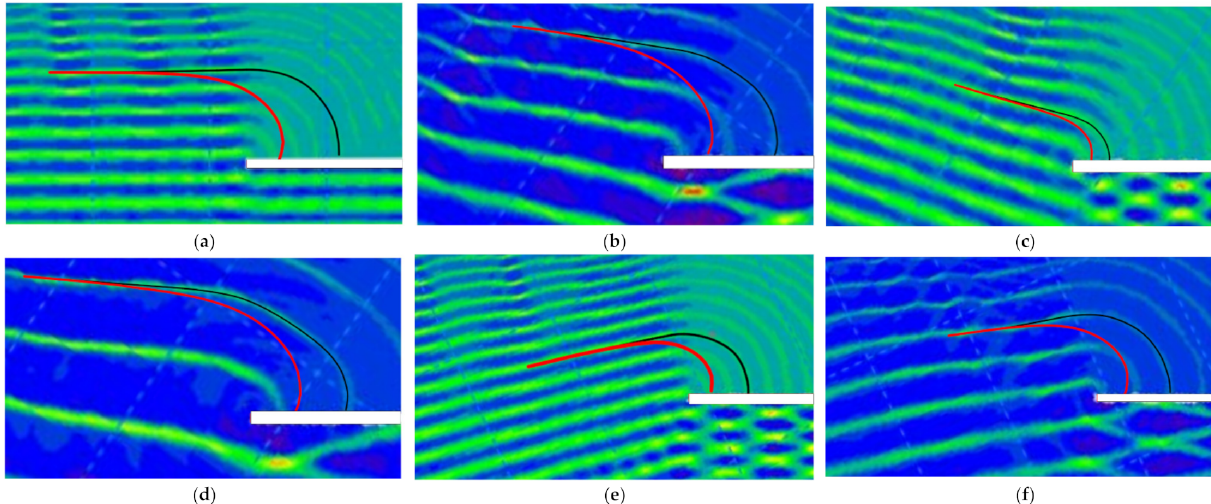
Figure 9. Comparisons between wave fronts (black line) and hyperbolic tangent profiles (red line): ( a ) wave direction 0 ◦ , wave period 6 s, gentle slope configuration; ( b ) wave direction − 35 ◦ , wave period 10s, gentle slope configuration; ( c ) wave direction − 35 ◦ , wave period 6s, gentle slope configuration; ( d ) wave direction − 35 ◦ , wave period 15 s, gentle slope configuration; ( e ) wave direction 25 ◦ , wave period 6 s, gentle slope configuration; ( f ) wave direction 25 ◦ , wave period 10 s, gentle slope configuration.